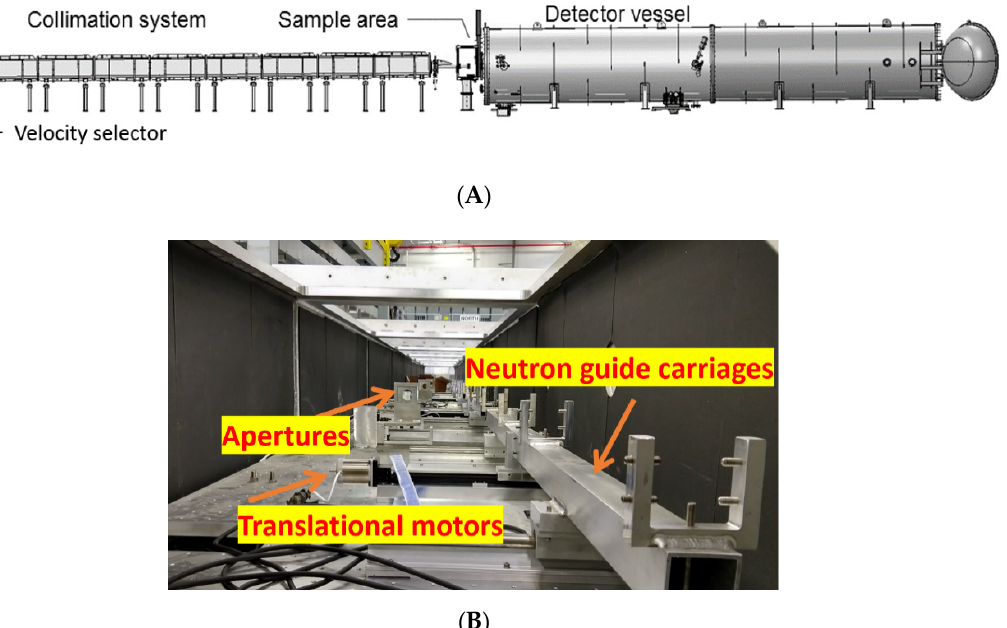
Figure 2. ( A ) An overview of a SANS instrument system. ( B ) The collimation system used at the biological small-angle neutron scattering instrument (Bio-SANS) and the general-purpose small-angle neutron scattering diffractometer (GP- SANS) with interchangeable neutron guide and aperture systems. There are eight sections of almost identical units with independent motor control.